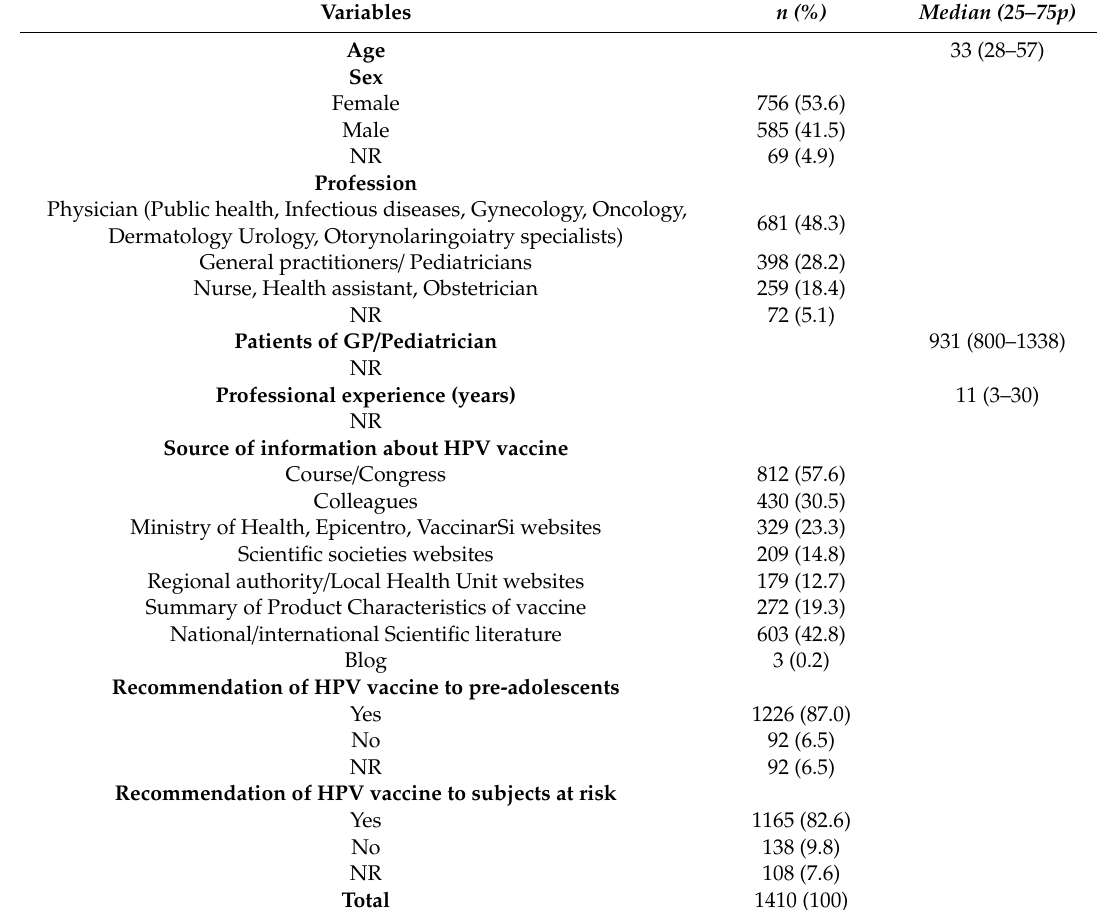
Table 1. Baseline characteristics of study